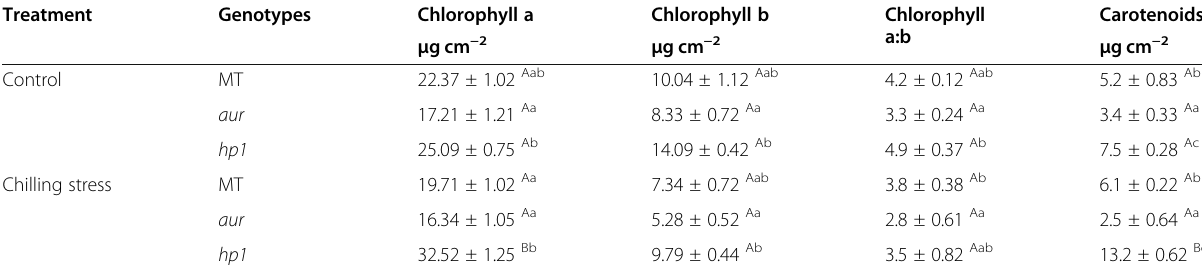
Table 1 Comparison of photosynthetic-related pigments in wild-type and two phytochrome mutants of tomato under chilling stress Treatment